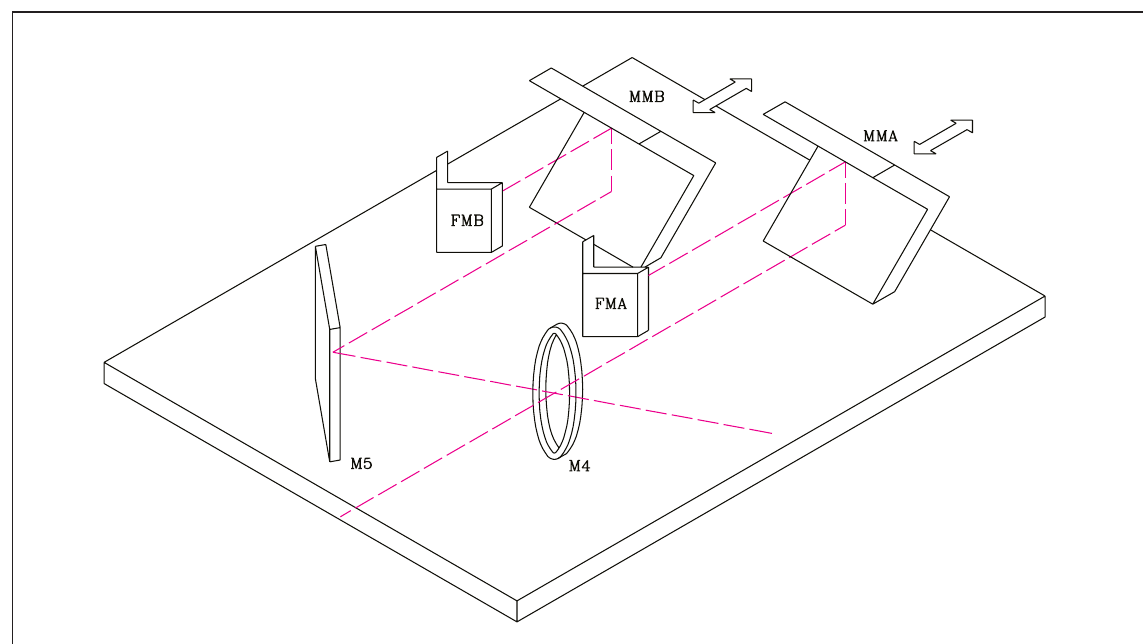
Fig. 7. The SAFIRE-A FIR